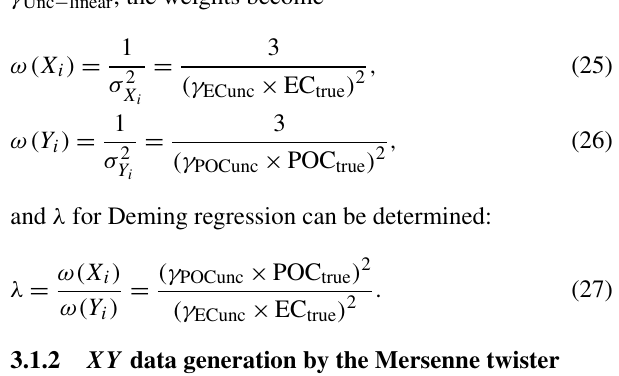
Figure 1. (a) Example γ Unc − nonlinear curves by different α val- ues (Eq. 17). The x axis is concentration (normalized by LOD) in log scale and the y axis is γ Unc . Black, blue and green line represents α equal to 1, 0.5 and 0.3, respectively, corresponding to the γ Unc − nonlinear at LOD level equals to 100, 50 and 30%, respectively. The red line represents γ Unc − linear of 10%. (b) Ex- ample of measurement uncertainty generation of γ Unc − nonlinear and γ Unc − linear . The blue circles represent γ Unc − nonlinear follow- ing Eq. (17) (LOD EC = 1, a EC = 1 ) . The red circles represent γ Unc − linear